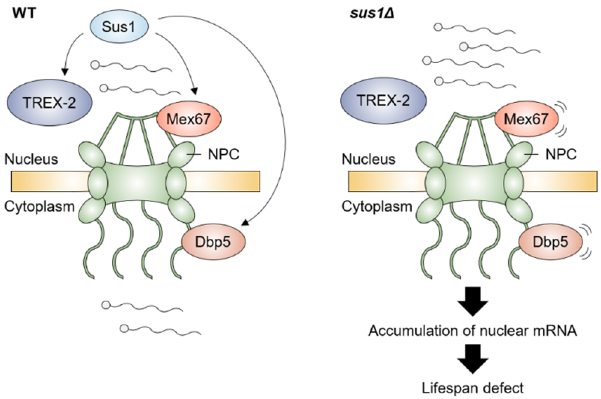
Figure 3. Sus1-mediated mRNA export pathway is required for maintaining a normal lifespan in yeast. In WT, Sus1, a component of TREX-2 complex, facilitates the proper association of Mex67 and Dbp5 with NPC, which requires efficient mRNA transport from nucleus to cytoplasm. In contrast, deletion of SUS1 leads to mislocalization of Mex67 and Dbp5 and accumulation of nuclear mRNA, resulting in a further defect in the lifespan. Illustration reflects the relevant location of proteins but not their precise physical association.